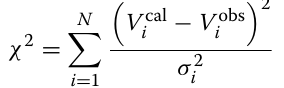
Fig. 2. Data from GNSS stations at 17 sites, 27 sites, and 44 sites, respectively, were used for the